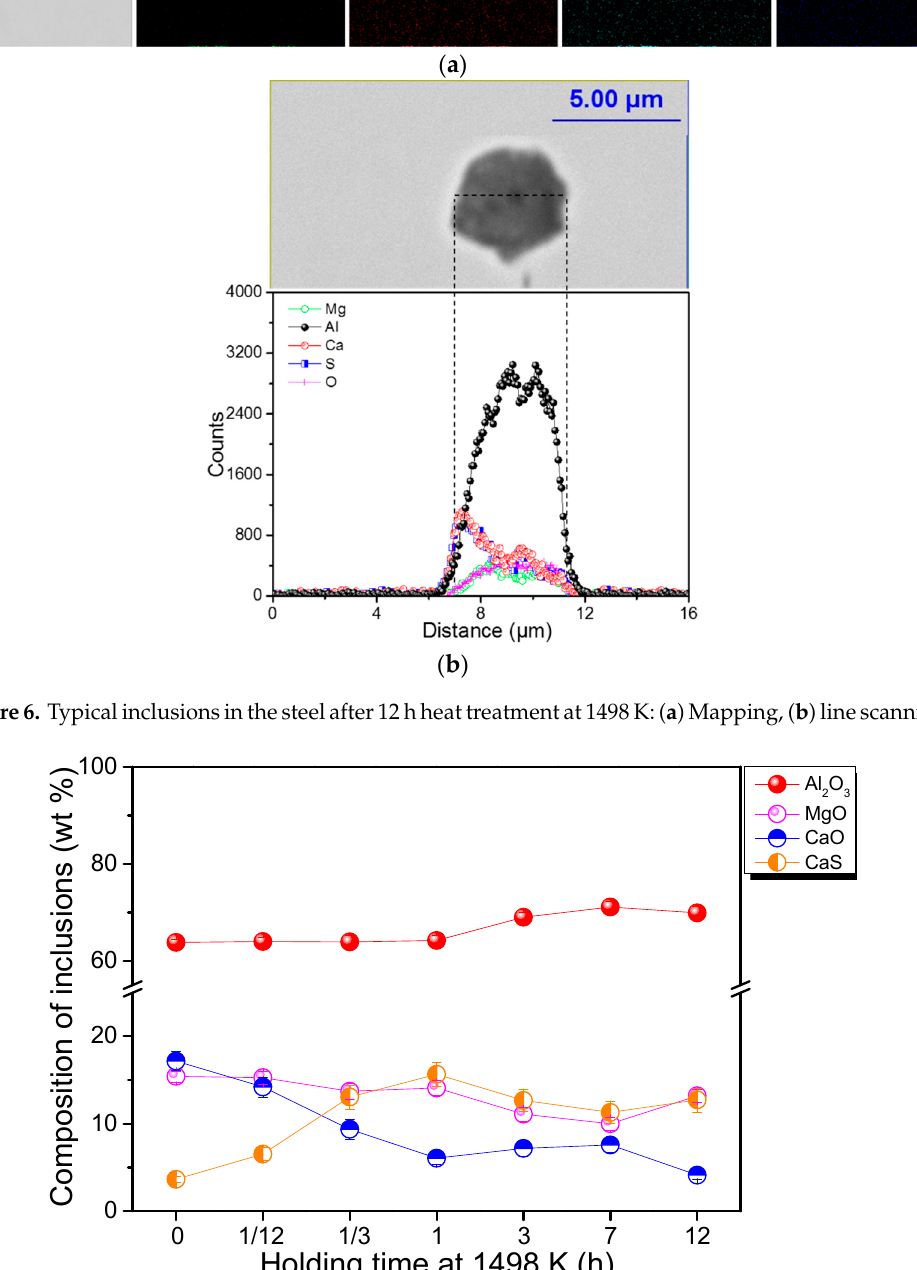
Figure 7. Effect of holding time on the average composition of inclusions at 1498 K.